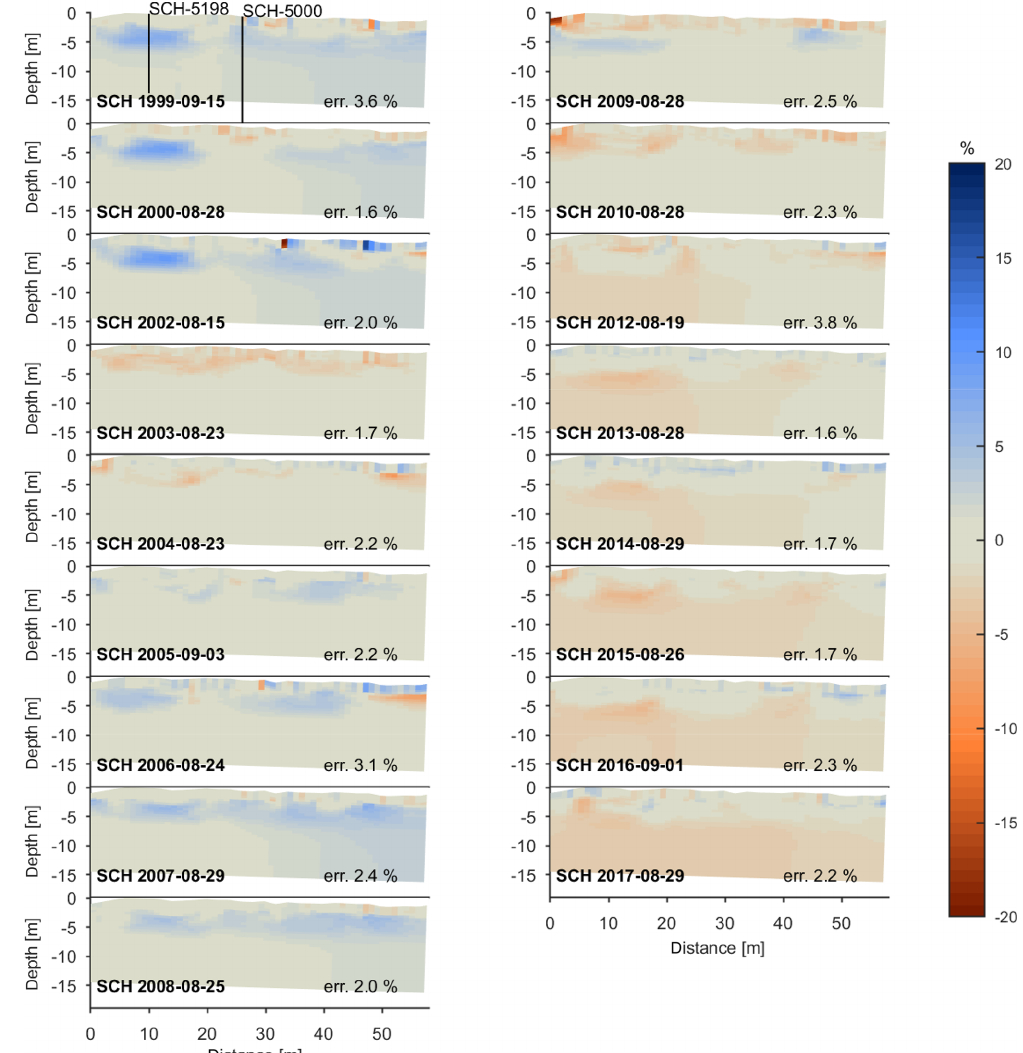
Figure 9. Resistivity logarithm percentage change tomograms with respect to the median of the end-of-summer time series at SCH. Black lines represent borehole